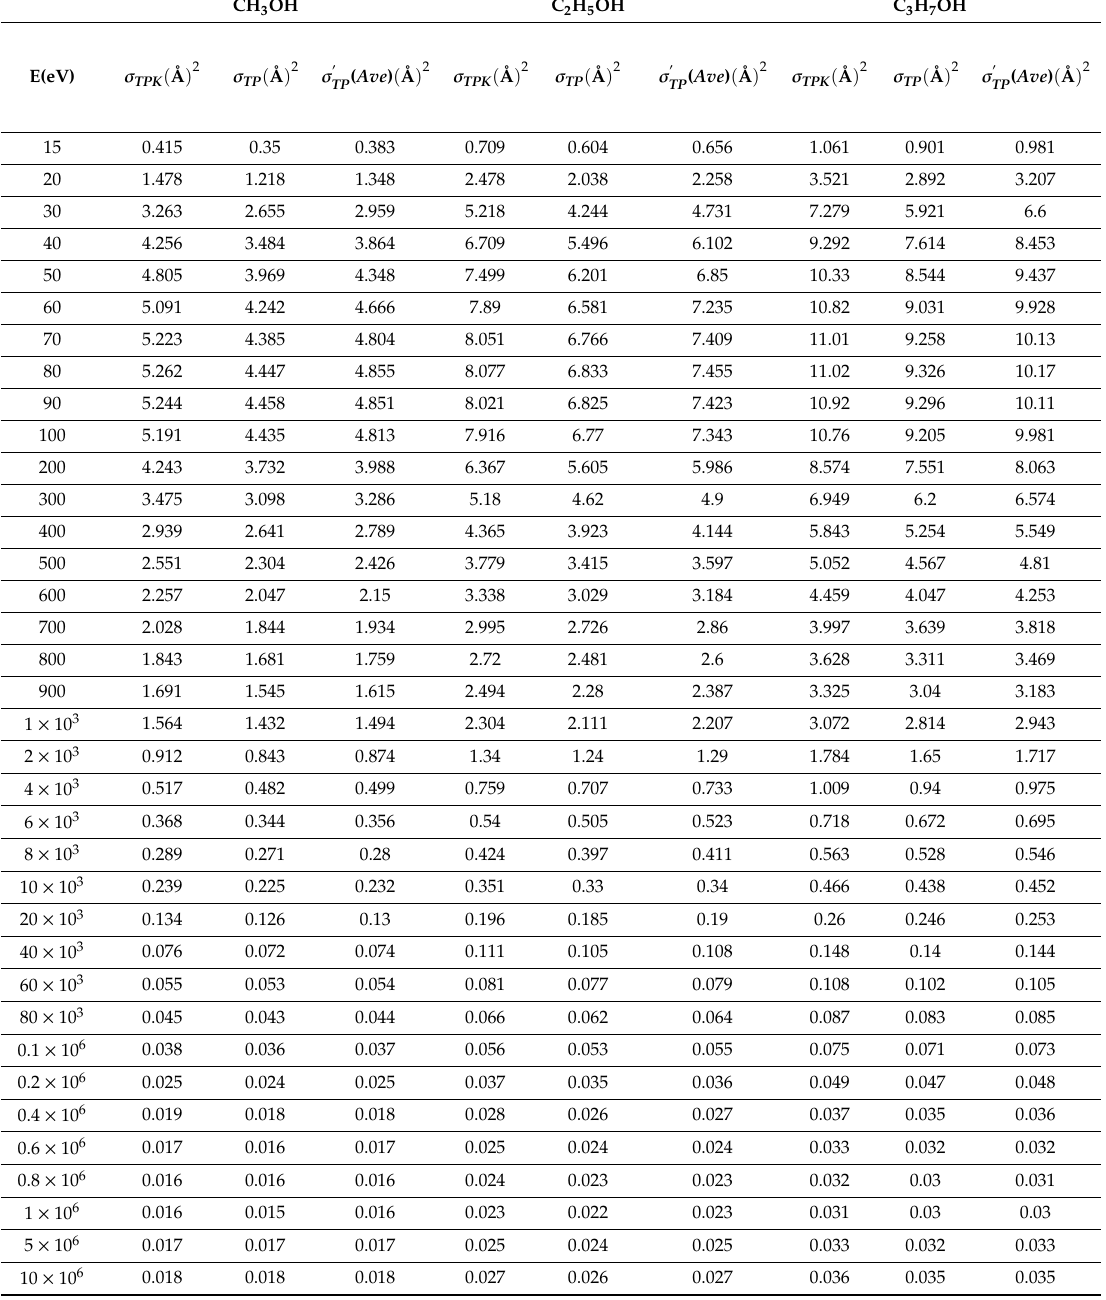
Table 1. This table represents the calculated present Khare BEB cross sections σ TPK , present cross sections σ TP (obtained by using CGOS of Weizsacker–Williams), and the present average cross sections (obtained by using the average CGOS) σ (cid:48) TP ( Ave ) , using Equations (16a–c). CH 3 OH C 2 H 5 OH C 3 H 7 OH E(eV) σ TPK ( Å )